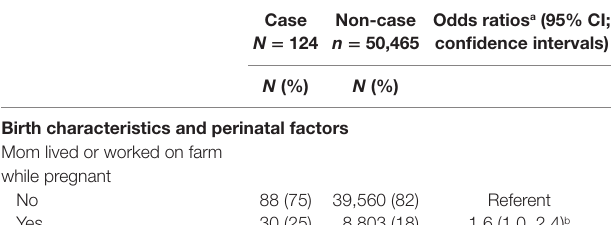
TaBle 2 | Perinatal and childhood sociodemographic risk factors for